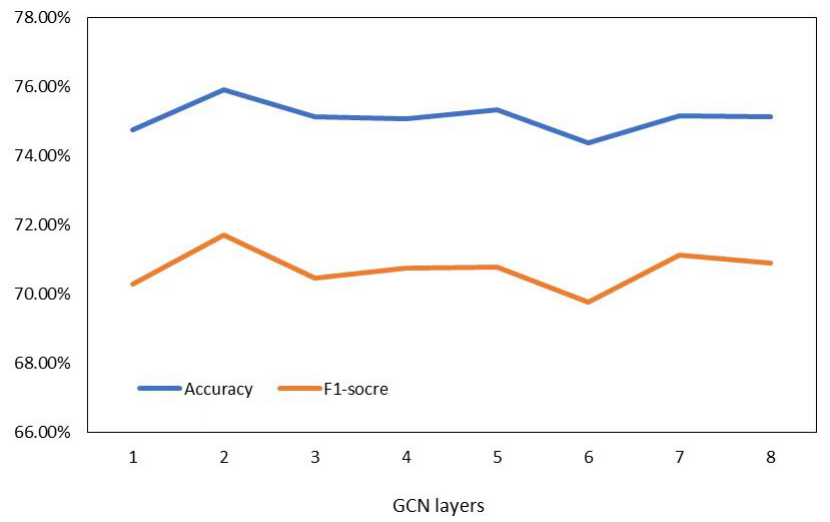
Figure 4. Impact of number of GCN